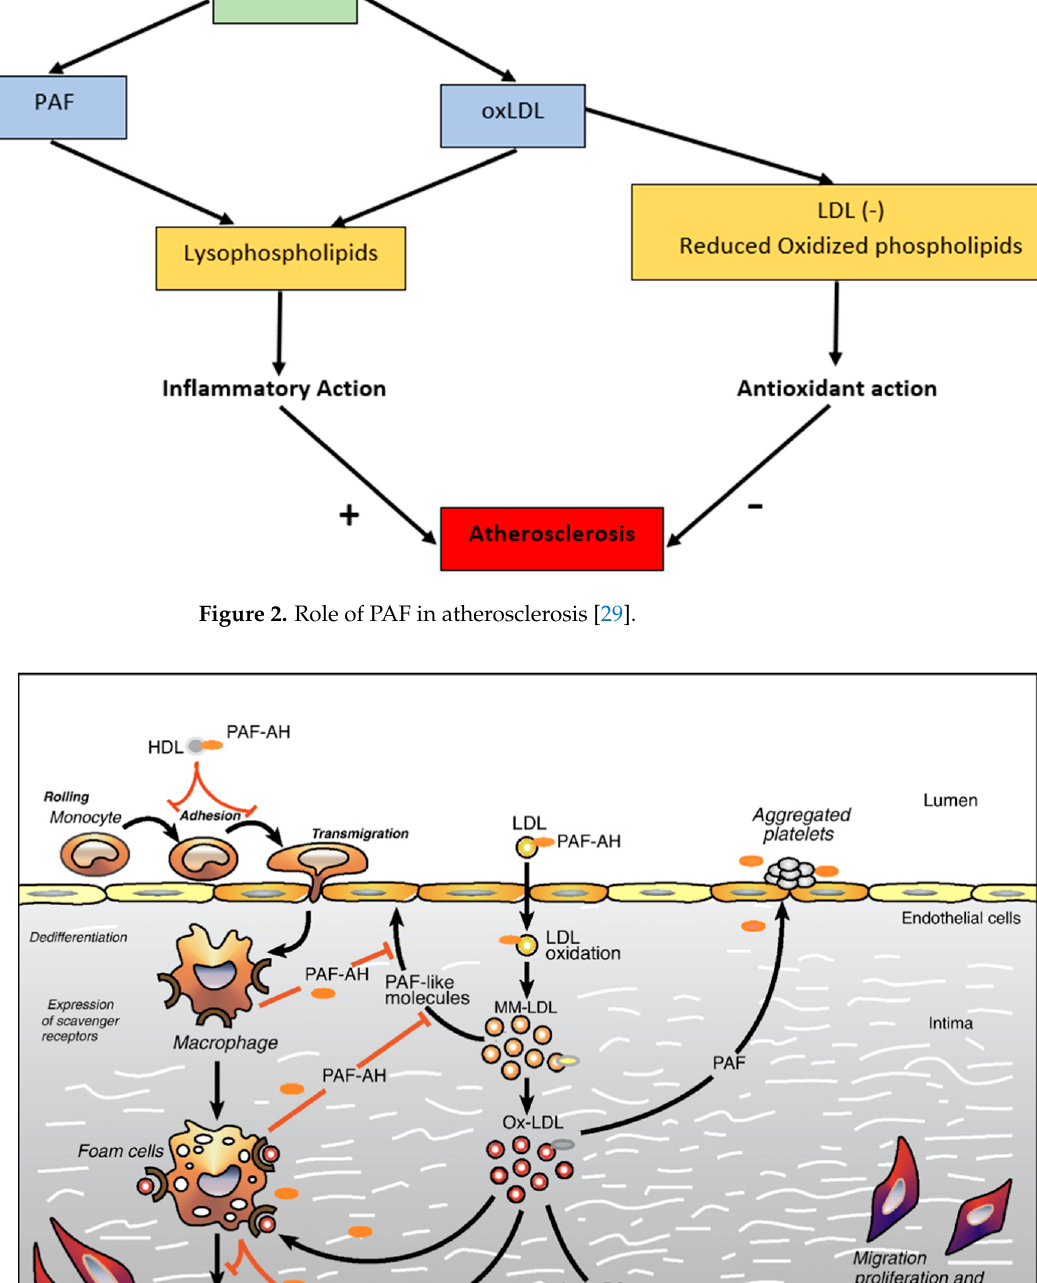
Figure 3. Relationship between PAF and atherosclerosis [30].